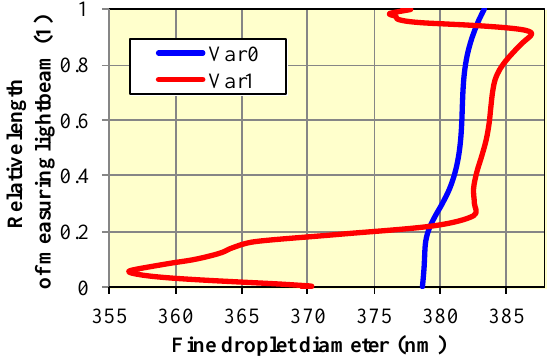
Fig. 7. Distribution of the average droplet diameter along the light beam